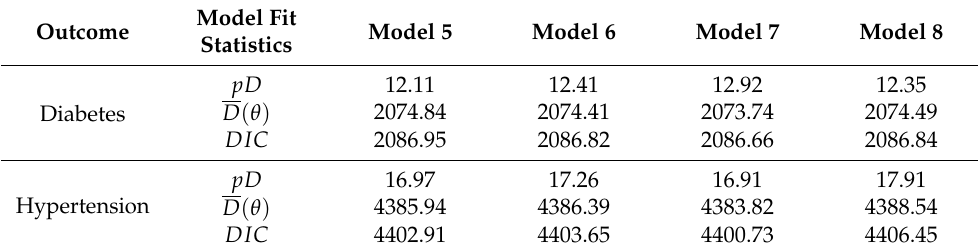
Table 3. Bayesian values of SVC model diagnostic